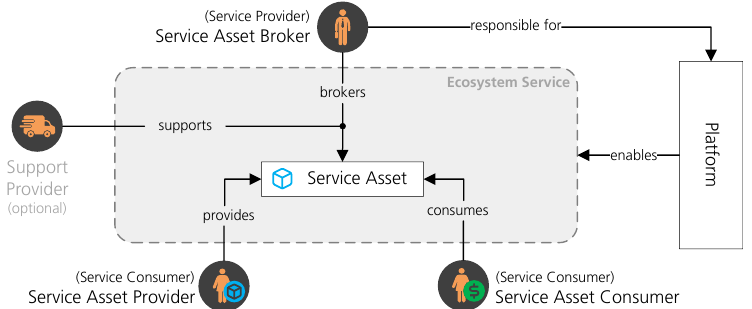
Figure 1. Overview of the elements of an ecosystem service [12]. Note that both the Service Asset Provider and the Service Asset Consumer are service consumers since they consume the digital ecosystem asset brokering